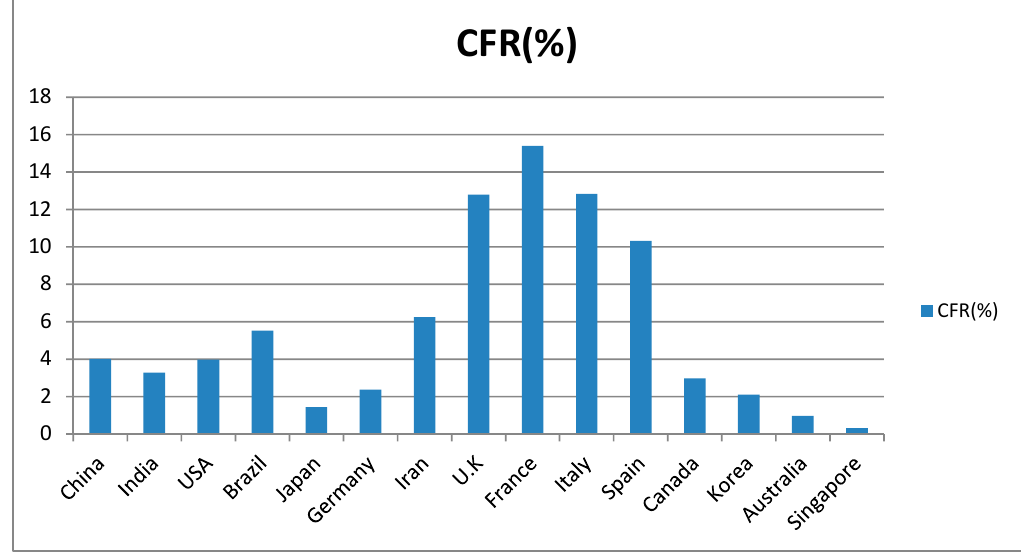
Figure 2. Case fatality rate (CFR) in some affected countries from Jan 21 till April 14, 2020